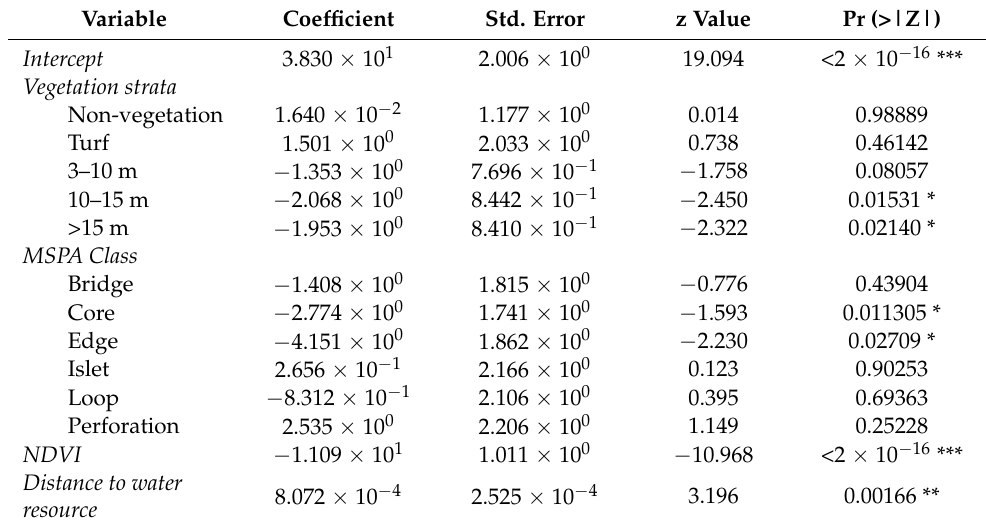
Table 5. Estimates for each independent variable from the multivariate model for predicting the LST.